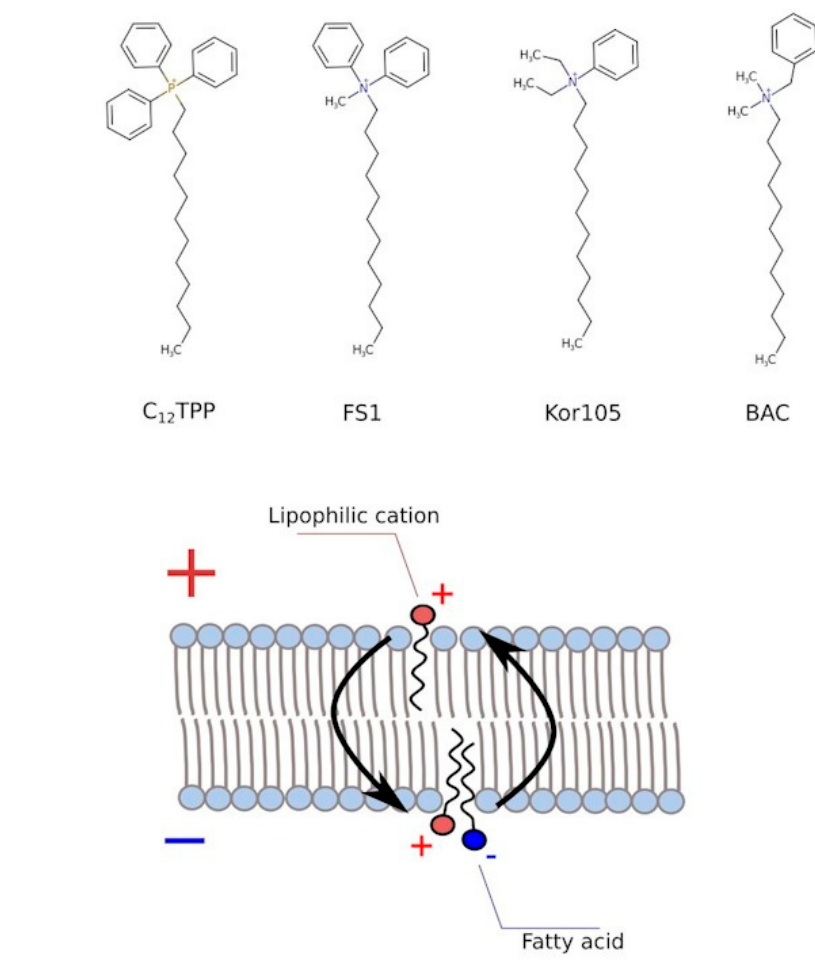
Figure 5. ( A ) Structural formulas of C 12 TPP and its analogs with varying degrees of charge shielding by phenyl groups. ( B ) A scheme illustrating the dissipation of the membrane potential by the lipophilic cations. “ + ” and “ − ” correspond to positive and negative electic charge, respectively.